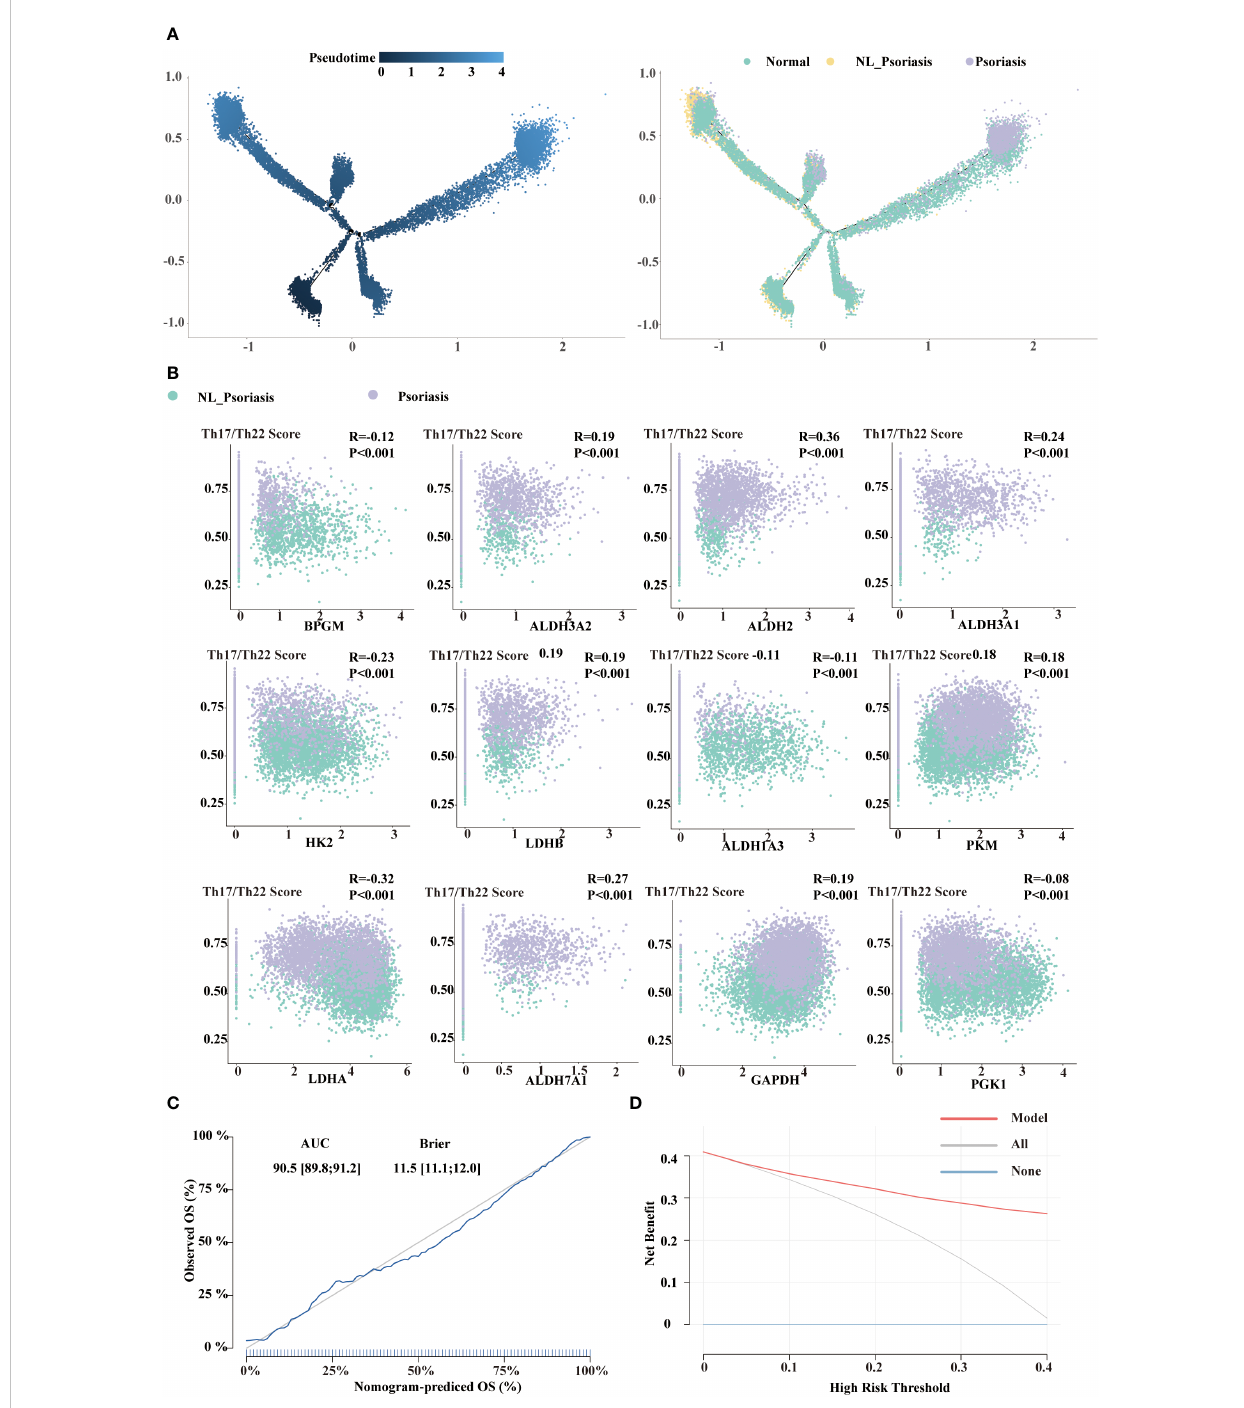
FIGURE 5 Construction of 12-gene signature. (A) Distribution of KC5 on the pseudo-time trajectory in a semi-supervised manner. Cells are colored based on pseudotime and tissue types. (B) The correlation between Th17/Th22 pathway activity and the selected signatures. (C) Calibration curve of the 12-gene signature model. (D) Decision Curve Analysis of the 12-gene signature